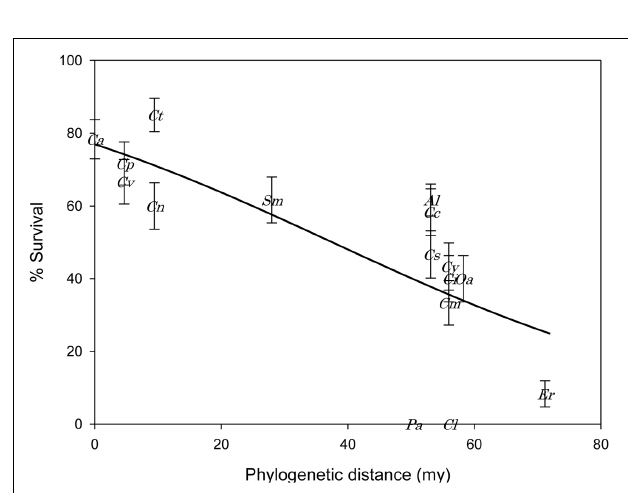
FIGURE 2 | Mean ( ± SE) percent survival of Cassida rubiginosa in relation to phylogenetic distance (million years, my) of each Cardueae test species from the primary host plant, Cirsium arvense . The relationship between % survival and phylogenetic distance (PD) is given by the equation, % survival = 100/[1 + exp( − 1.206 + 0.0321 × PD)]. Ct, Carduus tenuiflorus ; Ca, Cirsium arvense ; Cp = Cirsium palustre ; Cv, Cirsium vulgare ; Sm, Silybum marianum ; Al, Arctium lappa ; Cn, Carduus nutans ; Cc, Cynara cardunculus ; Cs, Cynara scolymus ; Cy, Centaurea cyanus ; Ci, Centaurea nigra ; Oa, Onoporodum acanthium ; Cm, Centaurea macrocephala ; Er, Echinops ritro ; Pa, Ptilostemon afer ; Cl, Carthamus lanatus